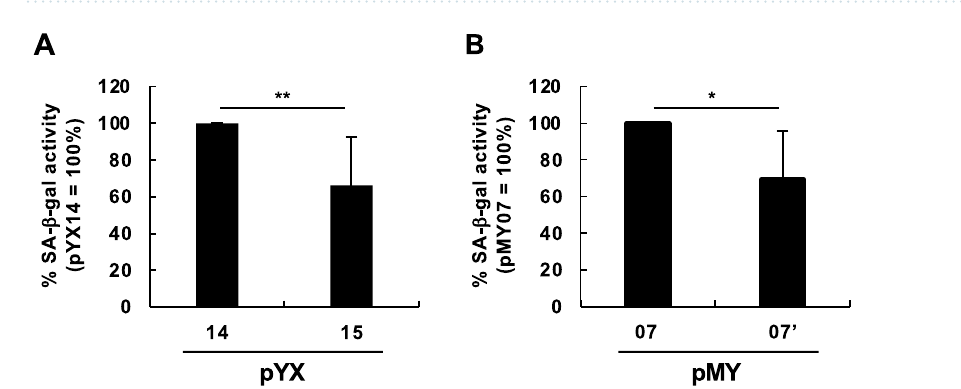
Figure 5. Cell senescence induced by NMR-L1 retrotransposition. ( A , B ) Cell senescence-associated β -galactosidase (SA- β -gal) activity induced by retrotransposition of a human L1 ( A ) and NMR-L1 ( B ). 293T cells were transfected with the indicated L1 reporter plasmids. SA- β -gal activity was evaluated at 3 days after transfection. Values are expressed as the mean + S.E. of four independent experiments. *, P <